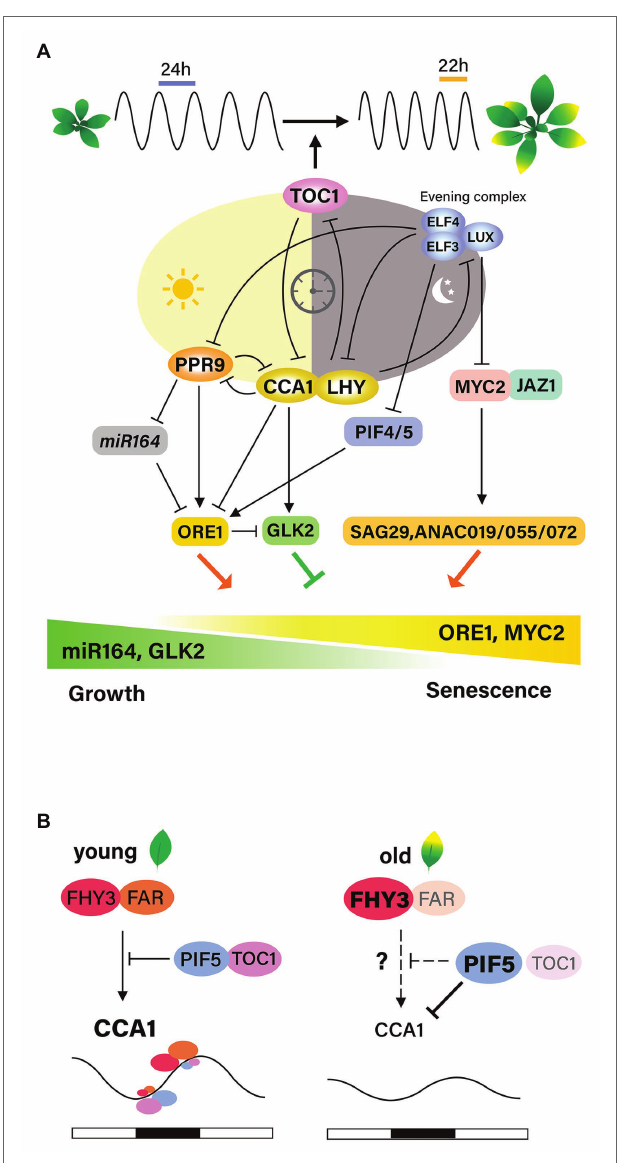
FIGURE 2 | Interactions between the circadian clock and leaf senescence. (A) Age information integrates with the circadian clock through TOC1, one of the core oscillators, resulting in the shortening of the circadian period with leaf senescence. Age-declined CCA1 induced the expression of ORE1 and suppression of GLK2 along leaf aging. PRR9 in the morning loop directly activates ORE1, and indirectly suppress miRNA164, forming the feed-forward pathway. The evening complex (EC) negatively regulates jasmonate-induced leaf senescence by repressing the expression of MYC2 . Inactivation of EC complex causes the activation of MYC2, which induces SAG29 , ANAC019 , ANAC055 , and ANAC072 , promoting leaf senescence. ELF3, a component of EC, negatively affects ORE1 expression by repressing PIF4/5. (B) FHY3/FAR1 is required for the light-induced expression of CCA1 and the role of FHY3/ FAR1 in activating CCA1 expression is antagonistically regulated by TOC1 and PIF5. Under diurnal cycle conditions, the high levels of FHY3 and FAR1 and low levels of PIF5 and TOC1 at the end of the evening contribute to the peak expression of the morning gene CCA1 before dawn. However, at aged leaves, FHY3 plays a role as a negative regulator of leaf senescence by suppressing WRKY28. Age-declined CCA1 expression might be due to PIF5, whose activity is increased at senescence